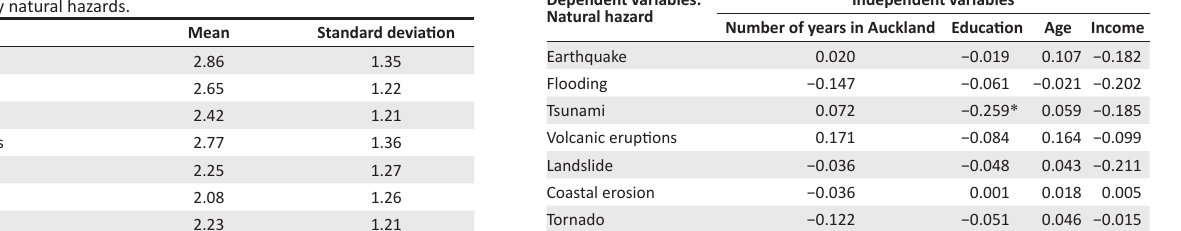
The negative correlation denotes an inverse relationship